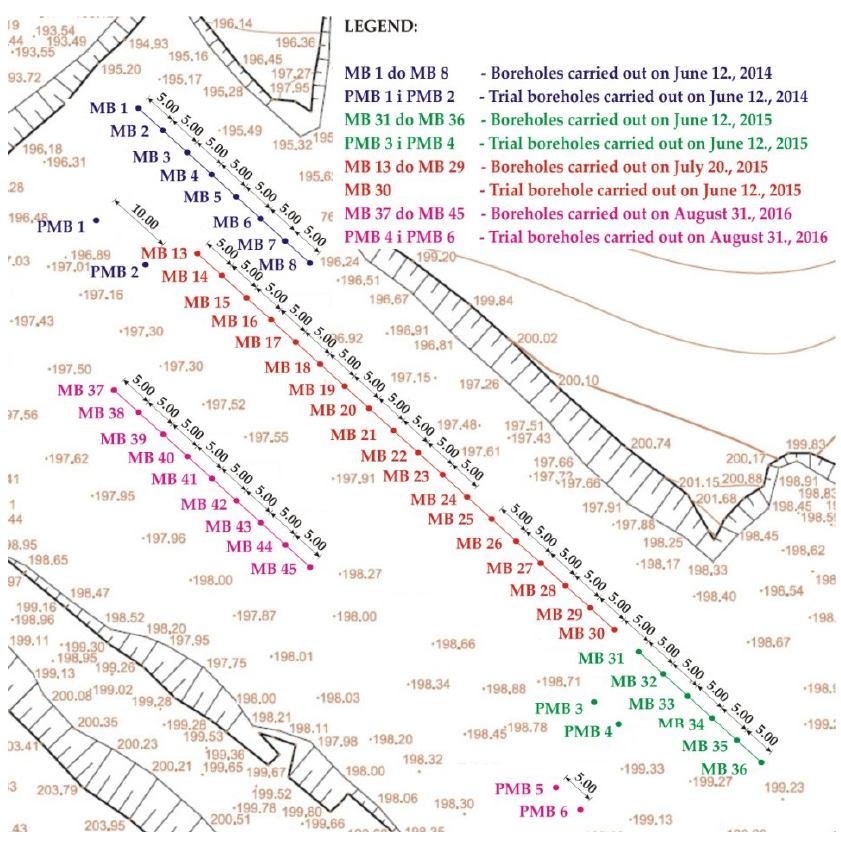
Figure 6. Exploitation field Cukavec II and positioned boreholes.